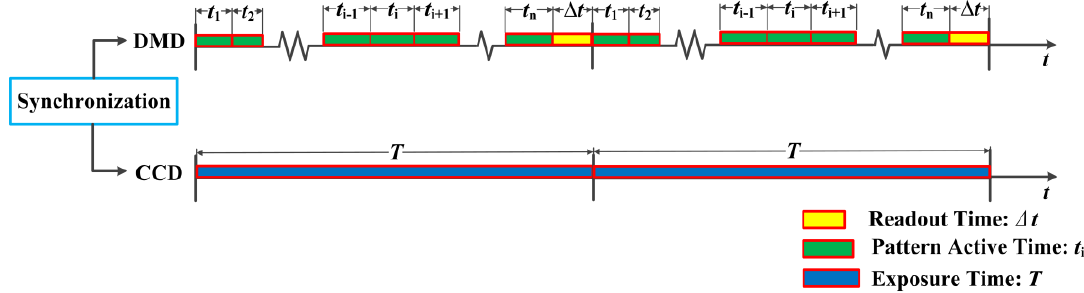
Figure 5. Sampling clock control of the DMD camera.